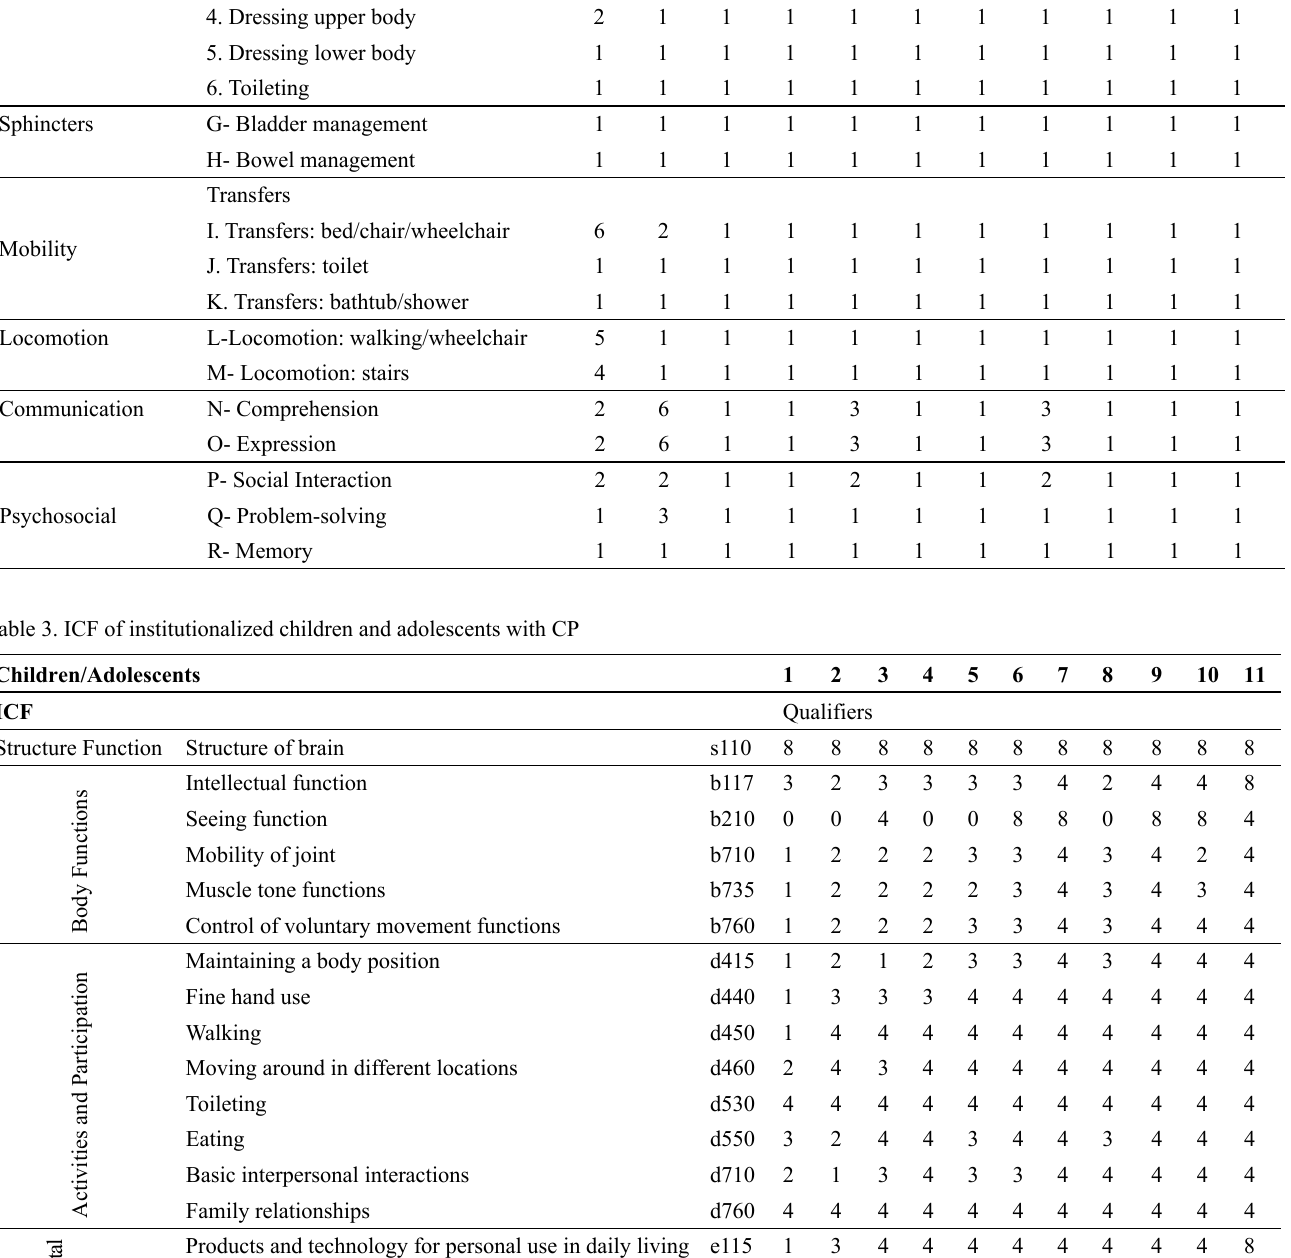
Table 2 . Functional Independence Measure scores of institutionalized Brazilian children and adolescents with CP Functional Independence Measure A- Eating